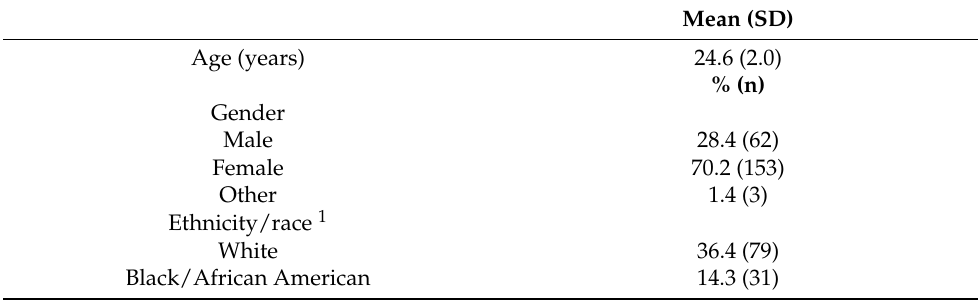
Table 1. Sample Characteristics during COVID-19 Mandatory Stay-at-Home Order (N =